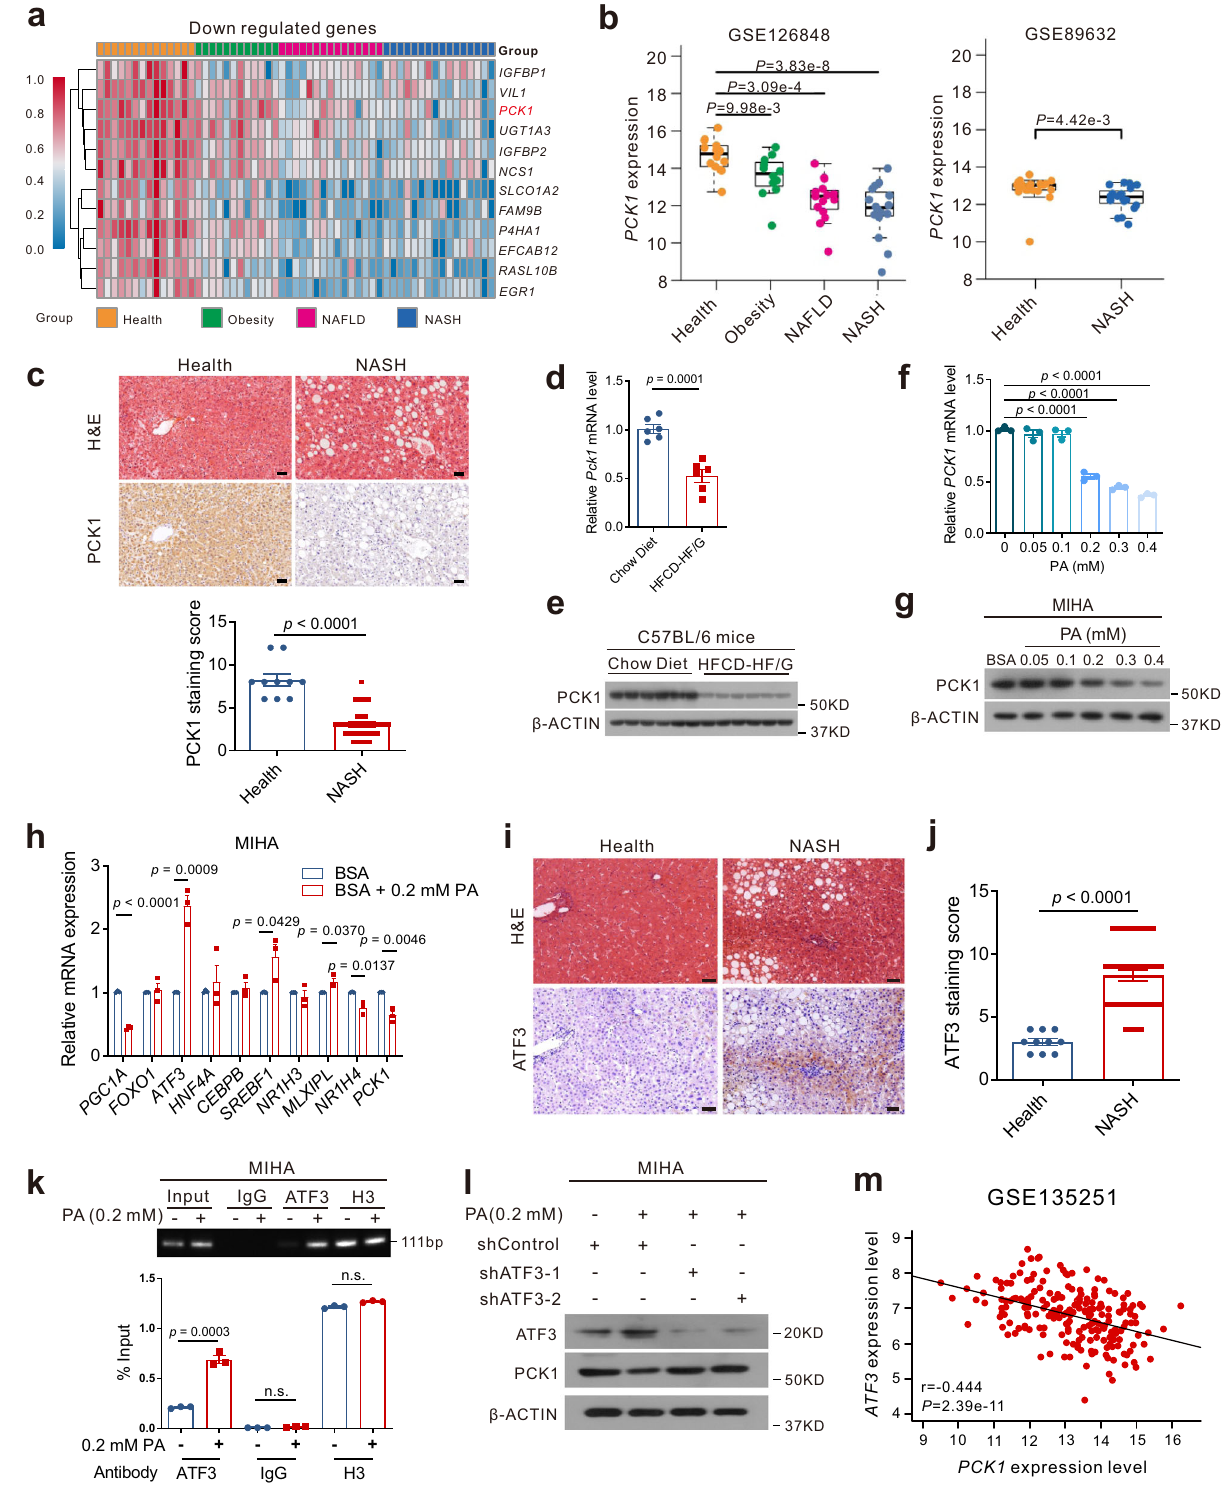
fat droplets, more severe fi brosis, and greater macrophage in fi ltration (Supplementary Fig. 3f, g). In agreement with increased in fl ammation and fi brosis, elevated expression levels of genes related to in fl amma- tion and fi brosis were observed in cPten f/f Pck1 f/f mice (Supplementary Fig. 3h). In summary, hepatic Pck1 depletion showed substantial liver steatosis, in fl ammation and fi brosis in PTEN-null